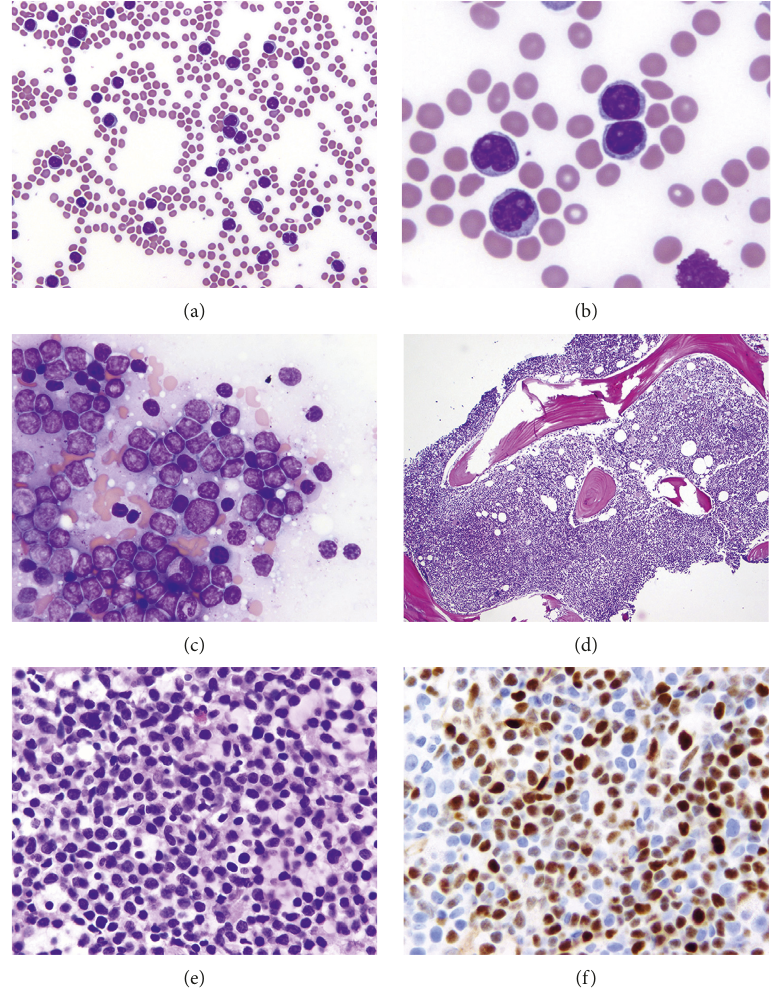
Figure 5: Case 2: peripheral blood and bone marrow biopsy. Wright Giemsa-stained peripheral blood smear shows lymphocytosis with many of the circulating lymphoma cells being small in size with round nuclear contours and minimal cytoplasm (a) 500x magnification. Approximately 50% of circulating lymphoma cells had more abundant cytoplasm and prominent nucleoli, consistent with prolymphocytic morphologic features (b) 1000x magnification. Bone marrow aspirate smear shows extensive involvement by lymphoma with a pre- dominance of cells having prolymphocytic features (c 1000x magnification). Hematoxylin and eosin-stained slides of bone marrow core biopsy show extensive marrow involvement by lymphoma ((d) 200x and (e) 500x magnification) with lymphoma cells being diffusely positive for cyclin D1 protein (f) 500x